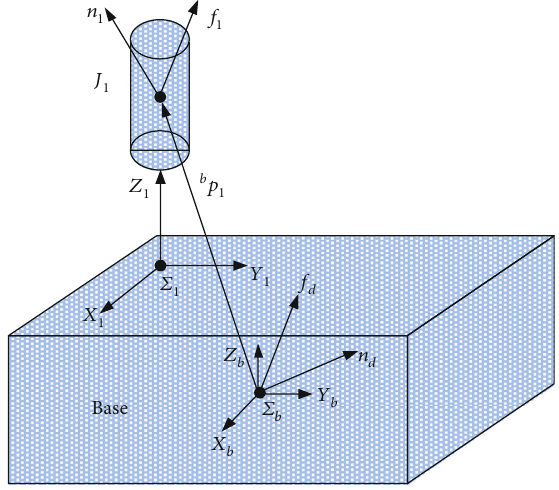
Figure 5: Solving model diagram of the disturbance